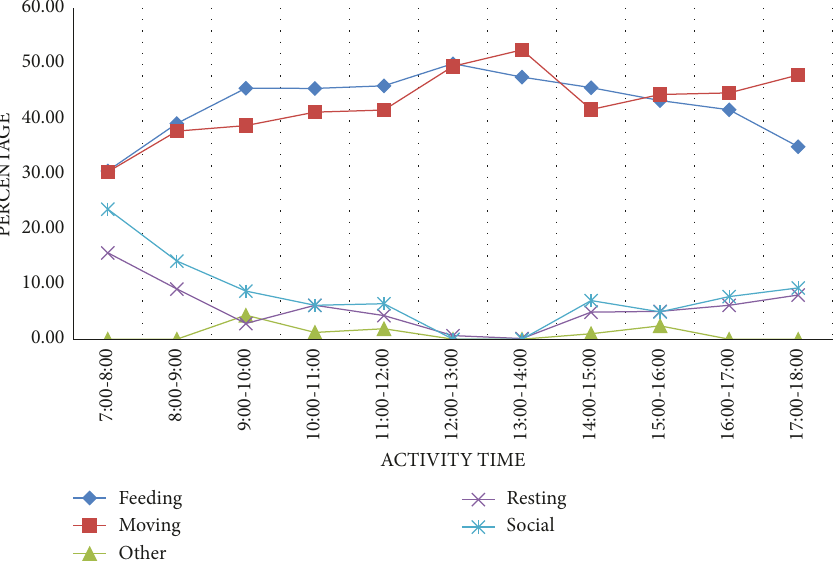
Figure 3: Daily activity pattern in grazed areas.